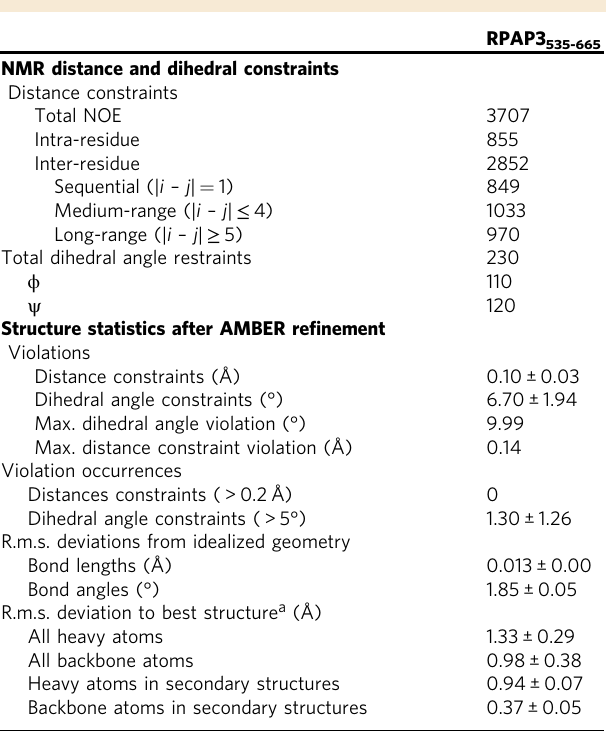
Table 1 NMR and re fi nement statistics for top-20 RPAP3 535-665